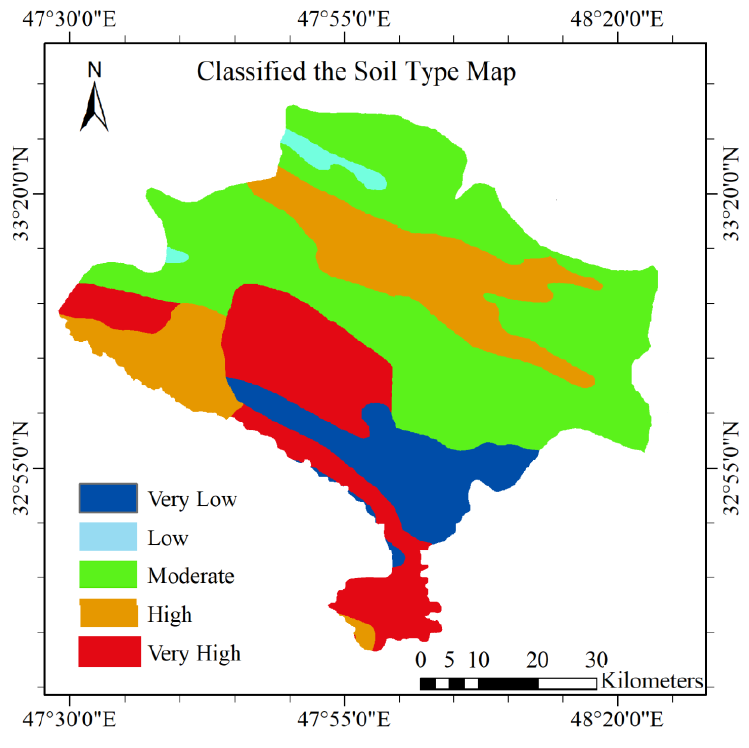
Figure 5. The reclassified soil type map of Pol-e Dokhtar based on the level of flood risk.